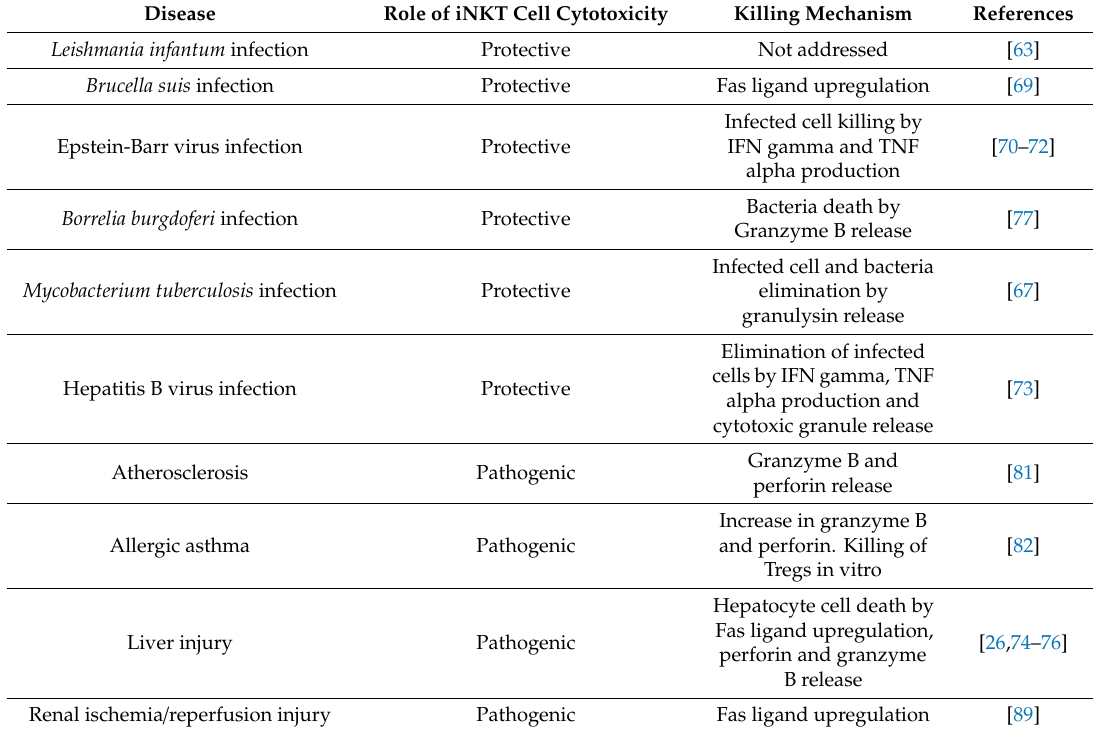
Table 2. Role of iNKT cell cytotoxicity in